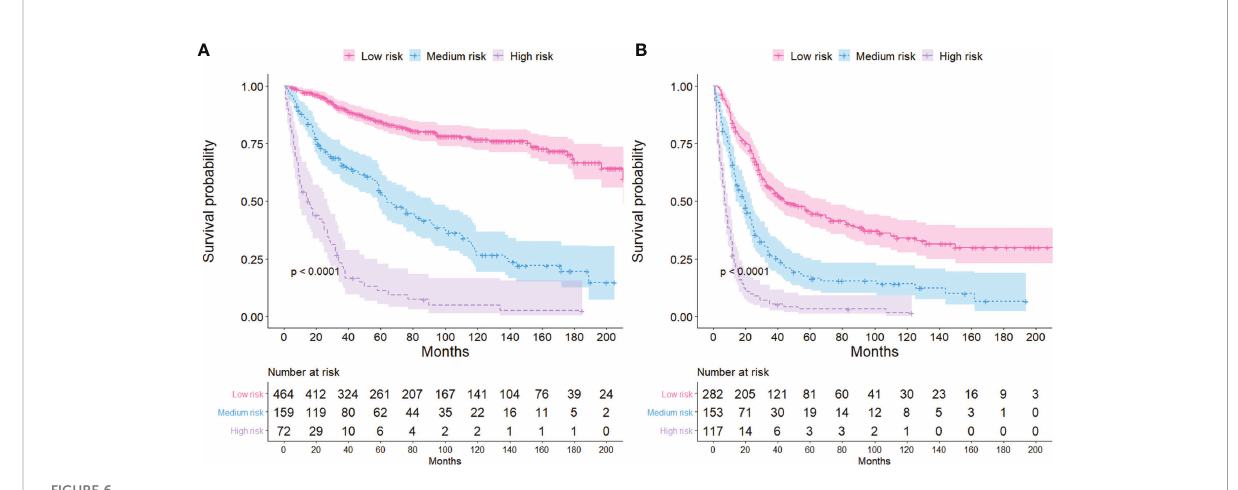
FIGURE 6 Kaplan-Meier survival curves for different risk groups among ECCC patients with FIGO stage I/II (A) and FIGO stage III/IV (B)